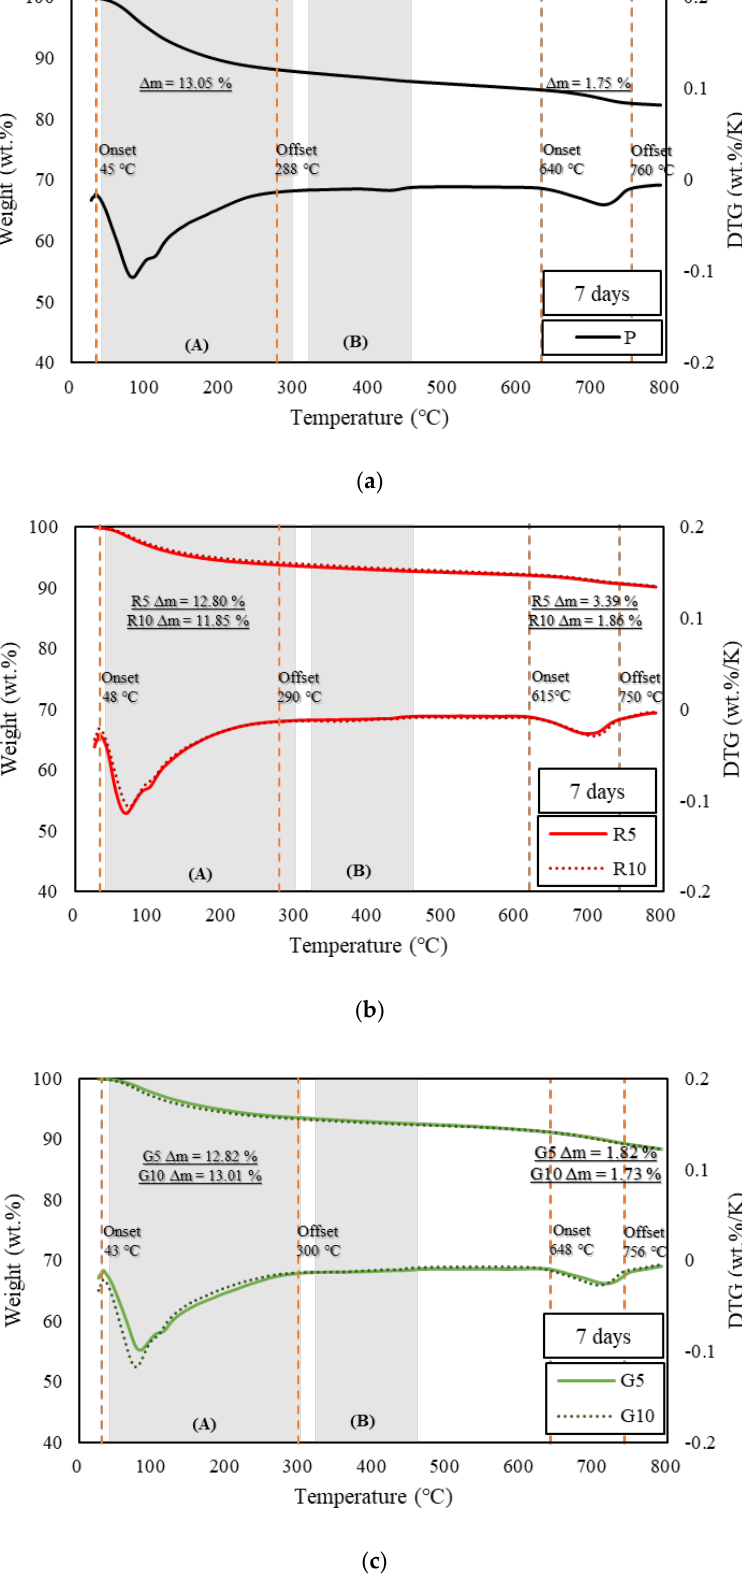
Figure 4. TGA of samples at seven days. ( a ) TGA results of specimen P at the age of seven days, ( b ) TGA results of specimens R5 and R10 at the age of seven days, and ( c ) TGA results of specimens GR5 and G10 at the age of seven days.